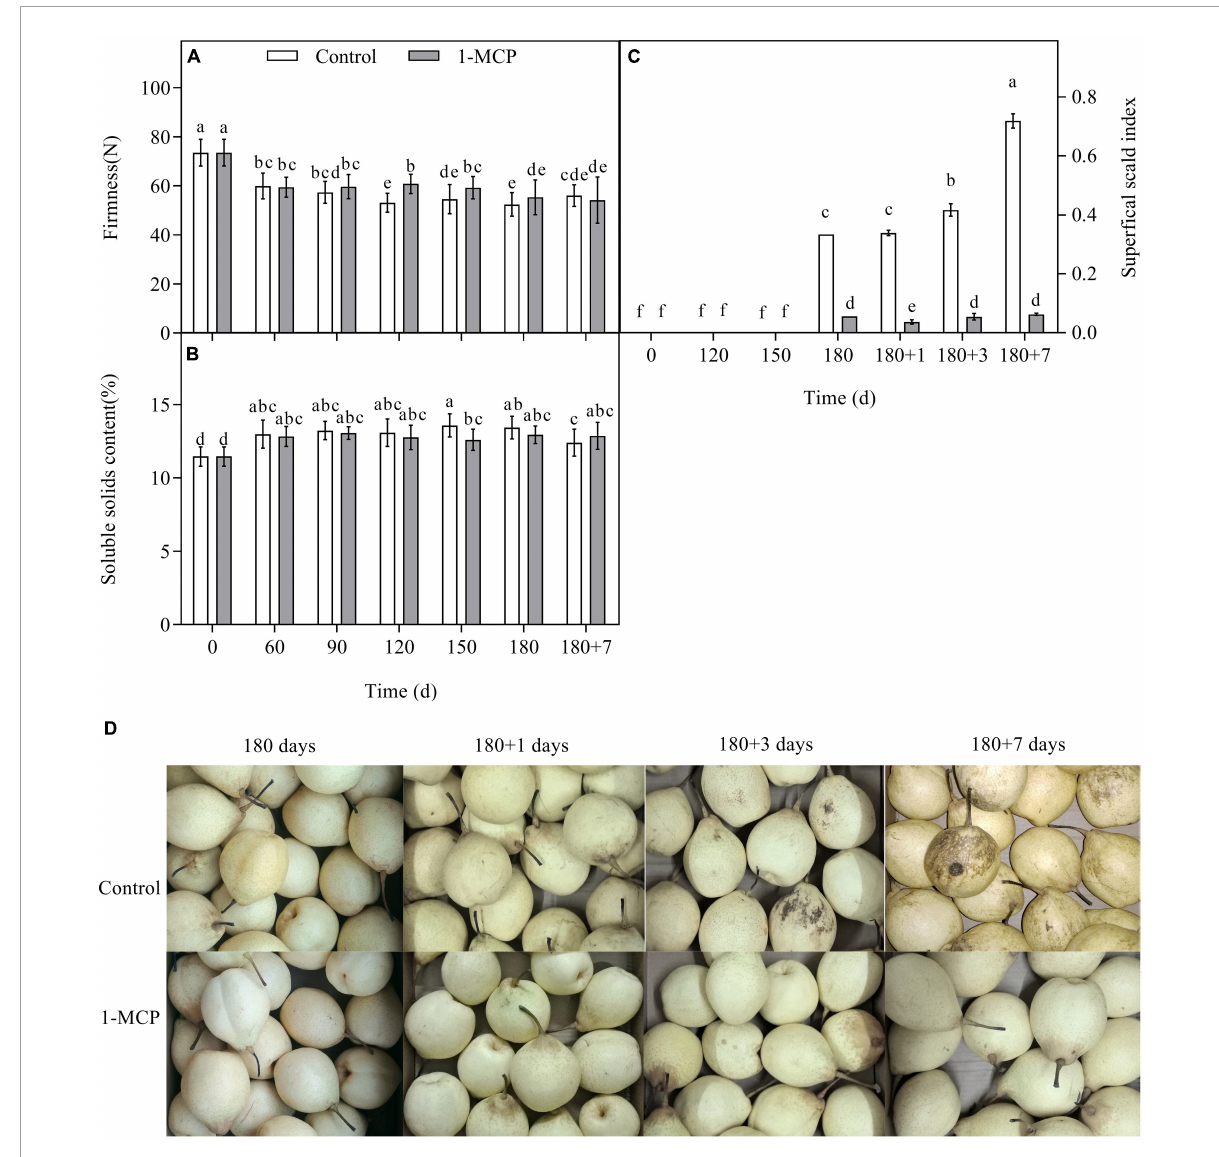
FIGURE1 Effect of 1-MCP on firmness (A) , SSC (B) , superficial scald index (C) , and symptom (D) in “Yali” pear during cold storage and shelf life. 180 + 1, 180 + 3, 180 + 7 indicated Days 1, 3, 7 at shelf life after 180 days of cold storage, respectively. All data are expressed as means ± standard errors of triplicate samples. Different letters indicate significant differences ( P < 0.05) by Duncan’s multiple comparison